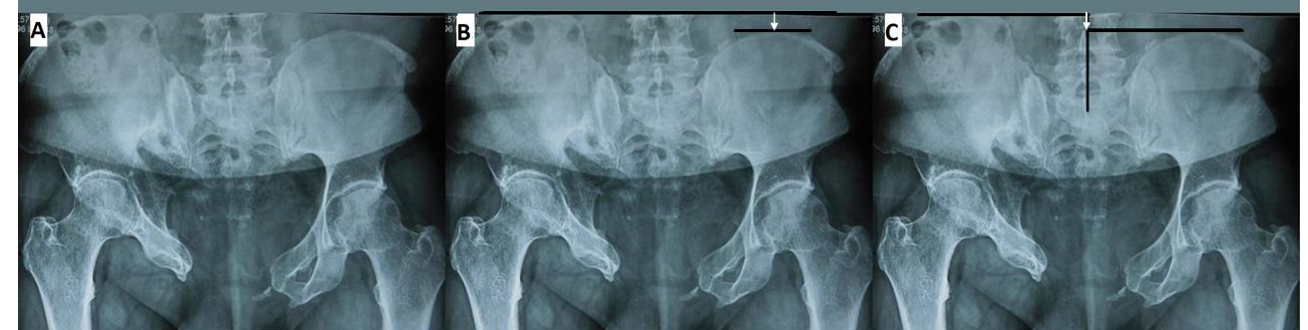
Figure 1. ( A ) Anteroposterior radiograph of a pelvic malunion with cranial vertical displacement of the right hemipelvis; ( B ) anteroposterior radiograph demonstrating measurement of vertical dis- placement of the right hemipelvis compared to the left (white arrow); ( C ) anteroposterior radio- graph demonstrating measurement of vertical displacement of each hemipelvis along perpendicu- lar vertical reference line (white arrow).